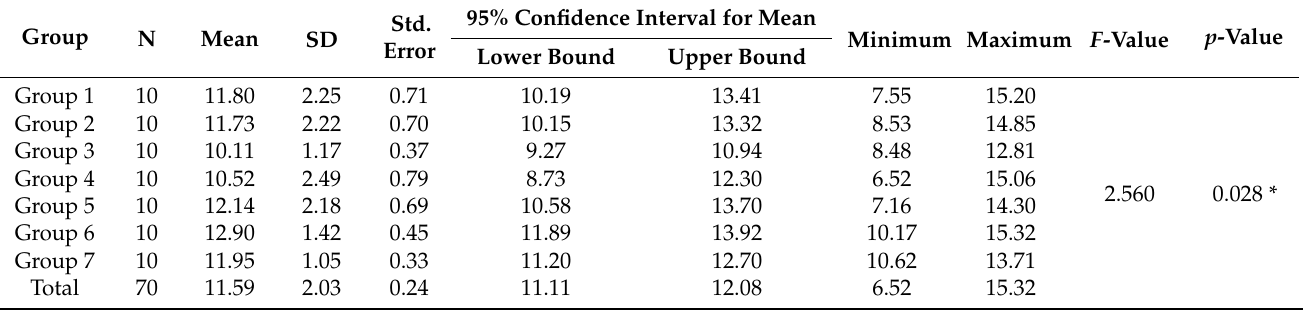
Table 1. One-way ANOVA for mean compressive stress (MPa) at maximum compressive